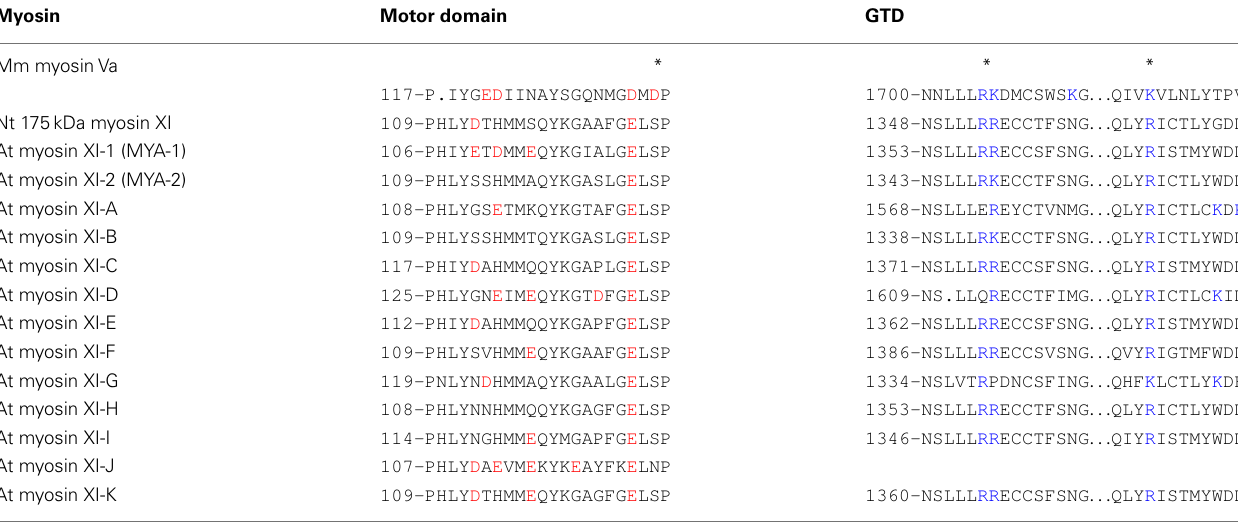
Table 3 | Sequence alignment of acidic residues in the motor domain and basic residues in